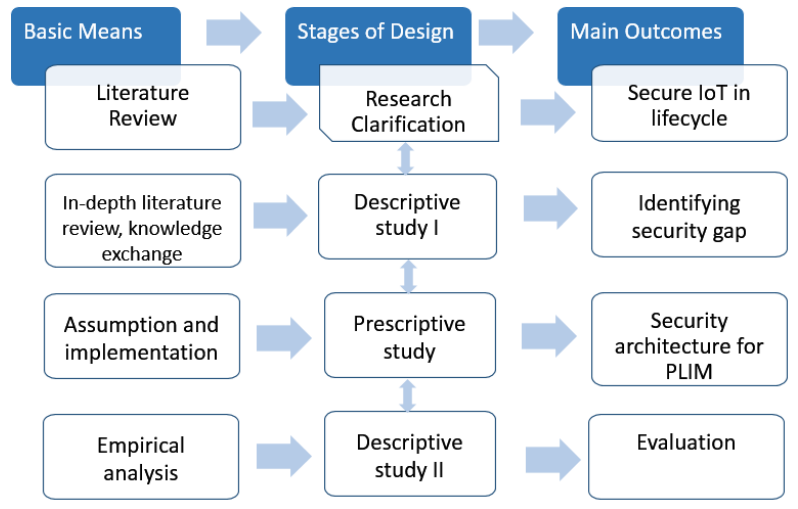
Figure 3. Stages of research